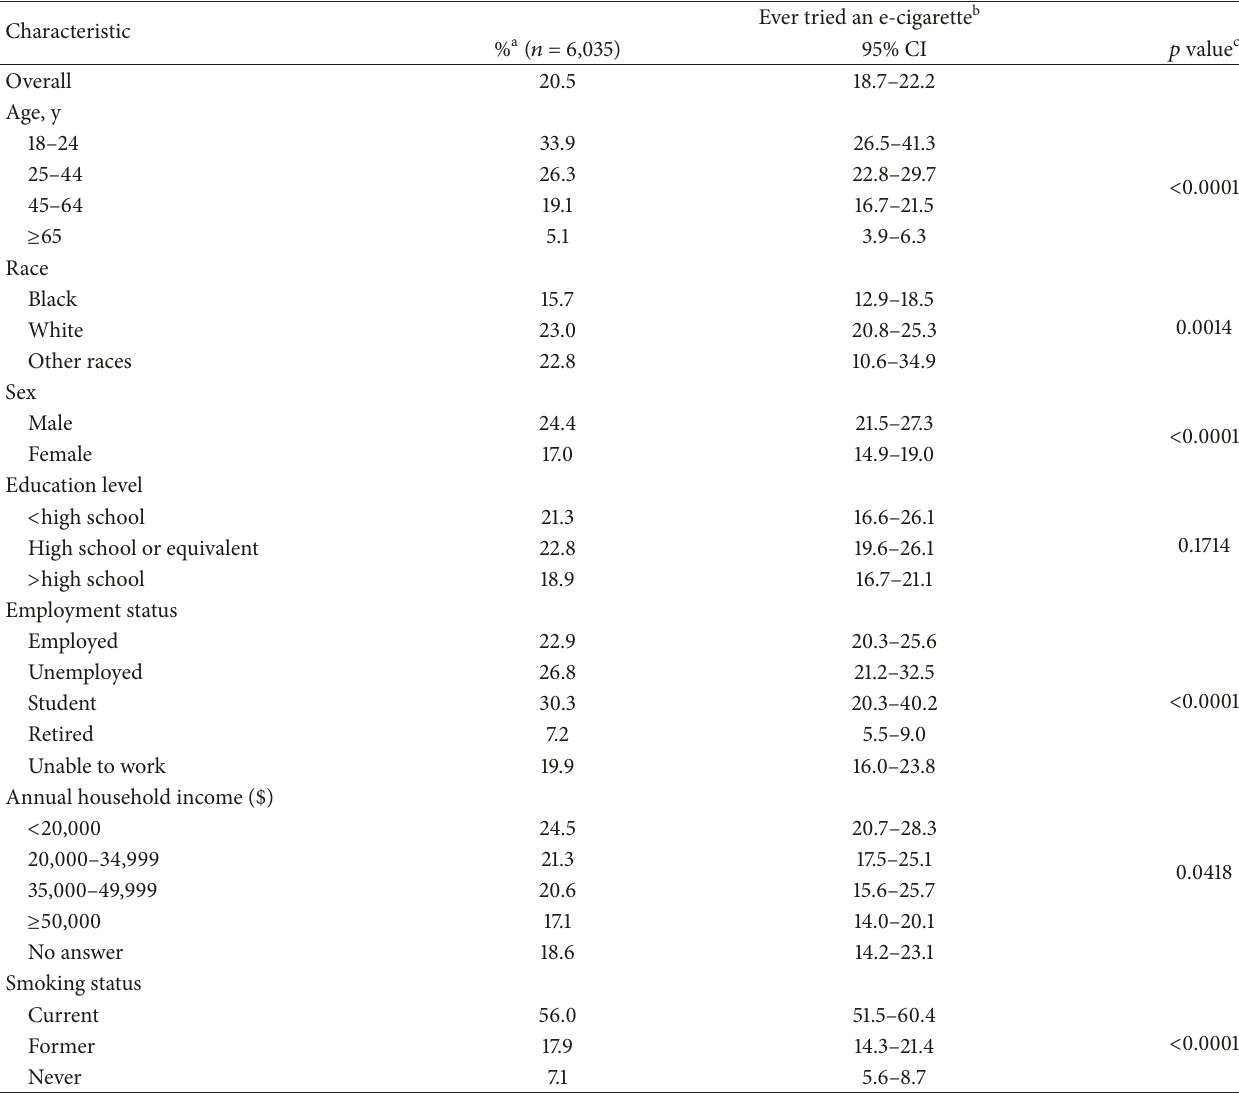
Table 2: Ever tried an e-cigarette by sociodemographic characteristics among Mississippi adults, Behavioral Risk Factor Surveillance System,